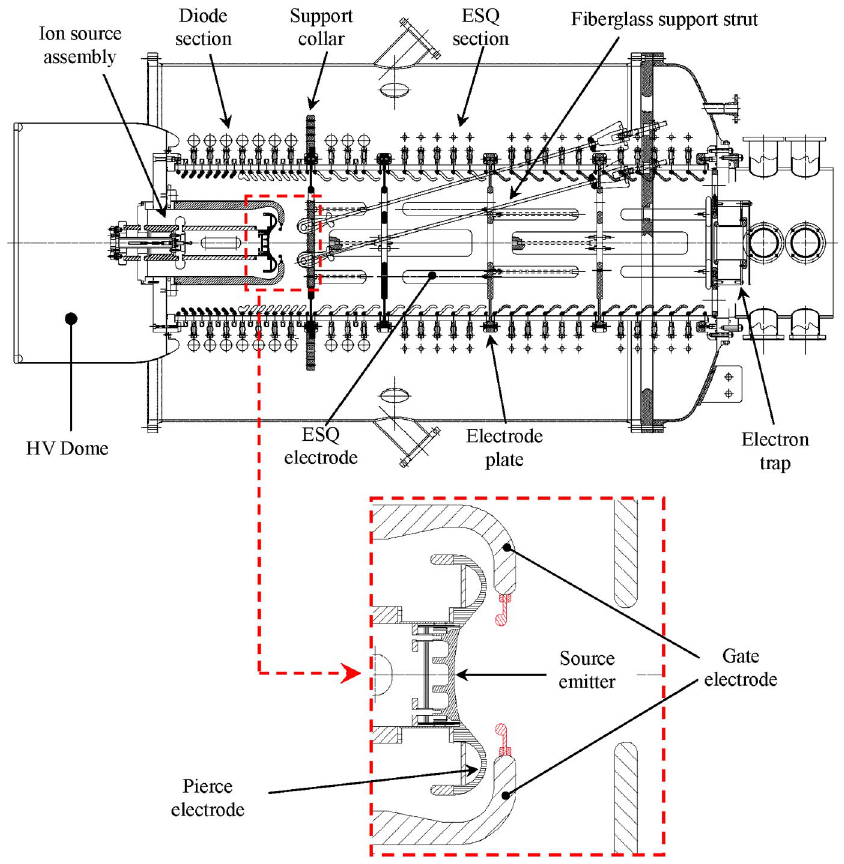
FIG. 1. (Color) 2-MV injector accelerator column showing fiberglass support struts. The column length is 2.4 m. The red part in the insert shows the addition to the gate electrode reducing its aperture diameter from 179.5 to 110